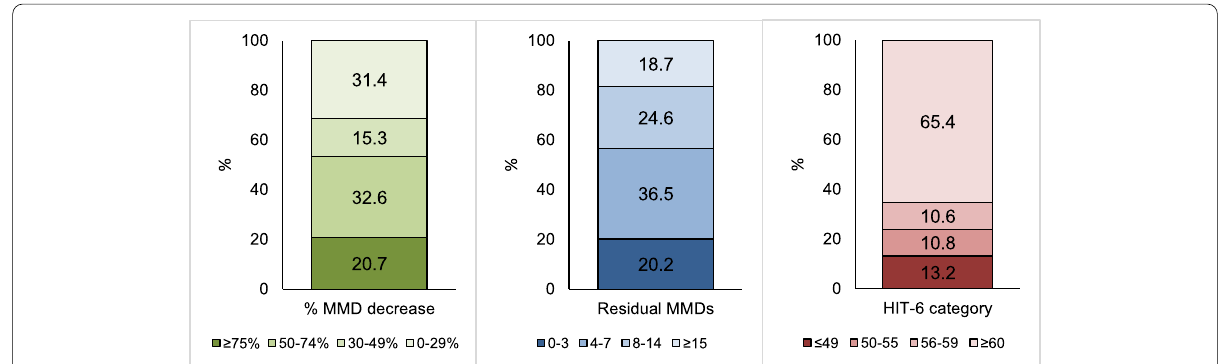
Fig. 1 Relative (percent decrease in monthly migraine days) and absolute (residual monthly migraine days and Headache Impact Test-6 score) response to